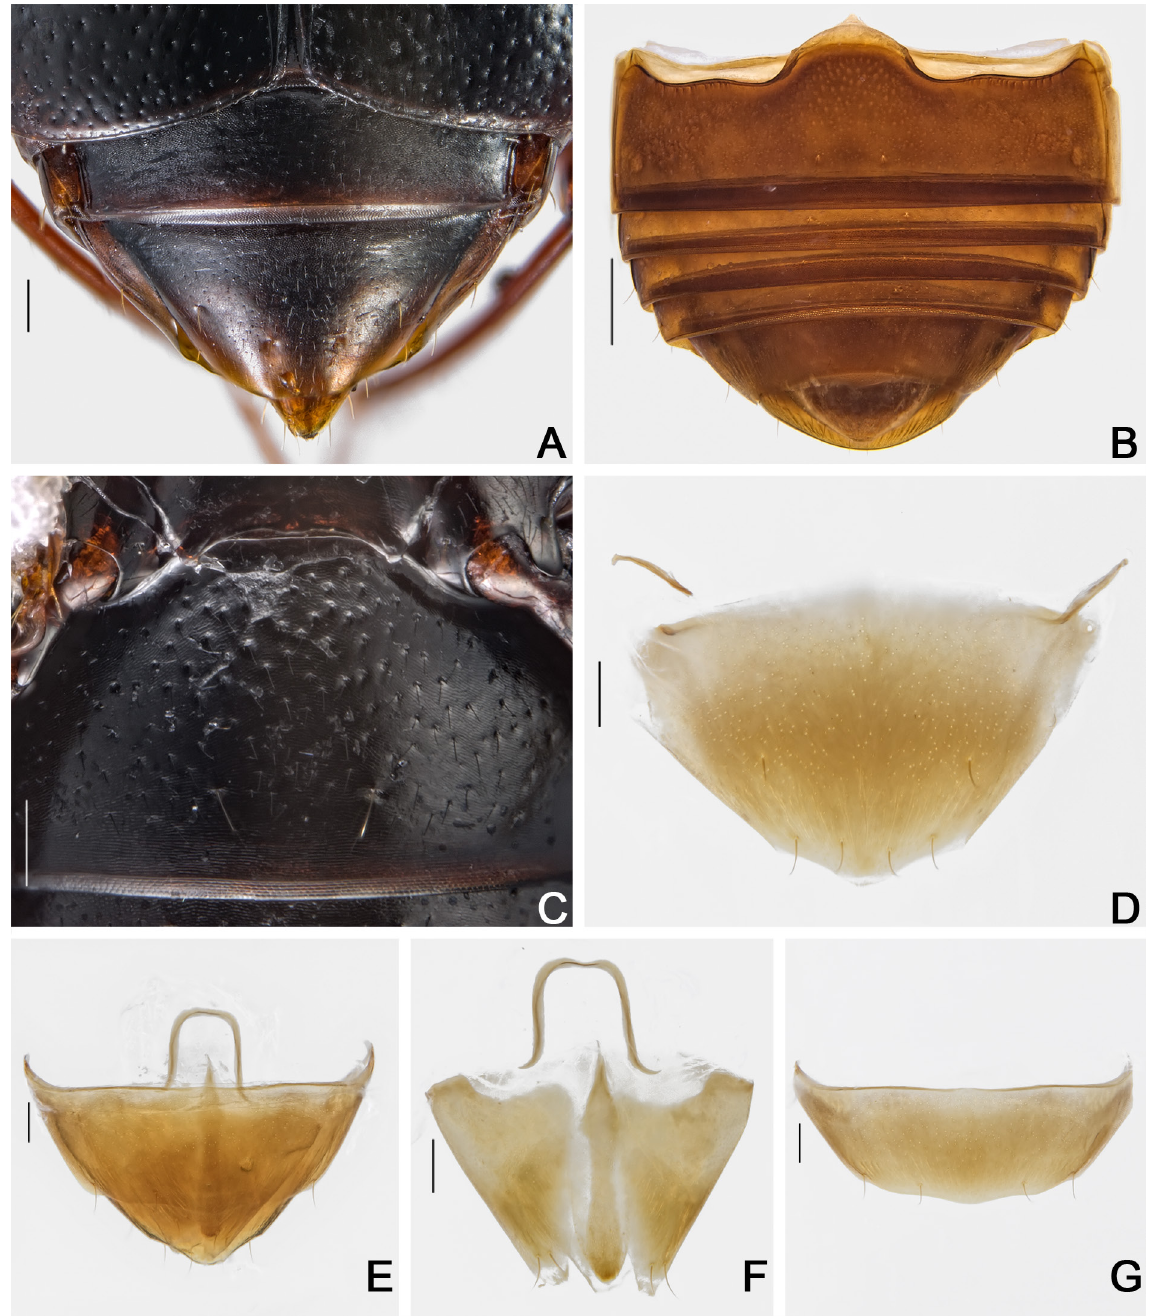
Fig. 61. Cyparium oberthueri Pic, 1956, ♂♂ (CELC). A–B . Abdomen. A . Dorsal view. B . Ventral view. C . Ventrite 1. D . Tergite VIII. E . Terminalia. F . Tergite IX. G . Sternite VIII. Specimens collected at Mata da Biologia, Viçosa (MG, Brazil). Scale bars: A, C–G = 0.2 mm; B = 0.5